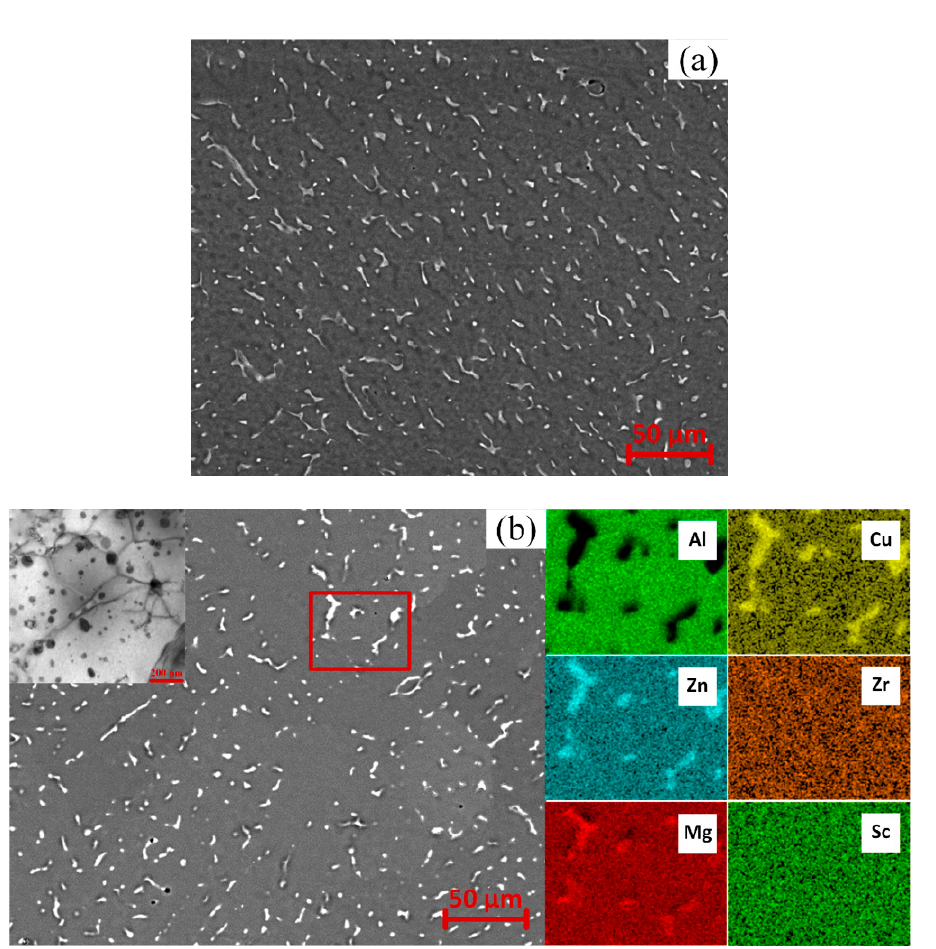
Figure 1. SEM-image of the alloy 0.15Sc as cast ( a ) and after the heat treatment ( b ). The images show the characteristic emissions of the alloying elements into the selected zone (the red rectangle on the microstructure) and TEM-image with secondary phases of T and Al 3 (Sc,Zr).